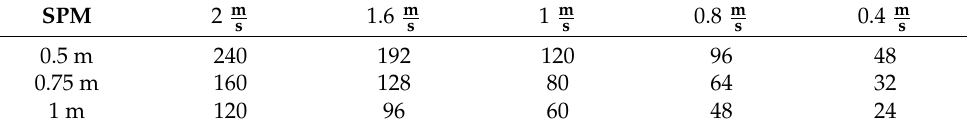
Table 2. Cadence for various speeds and stride lengths on a path of 10 m (SPM = strides per minute).